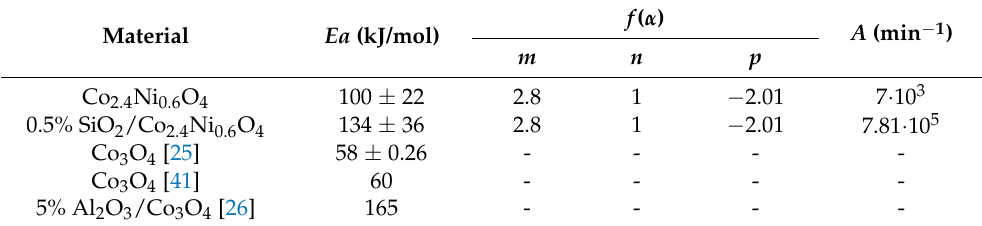
Kinetic triplet values describing the oxidation reaction of the Co 2.4 Ni 0.6 O 4